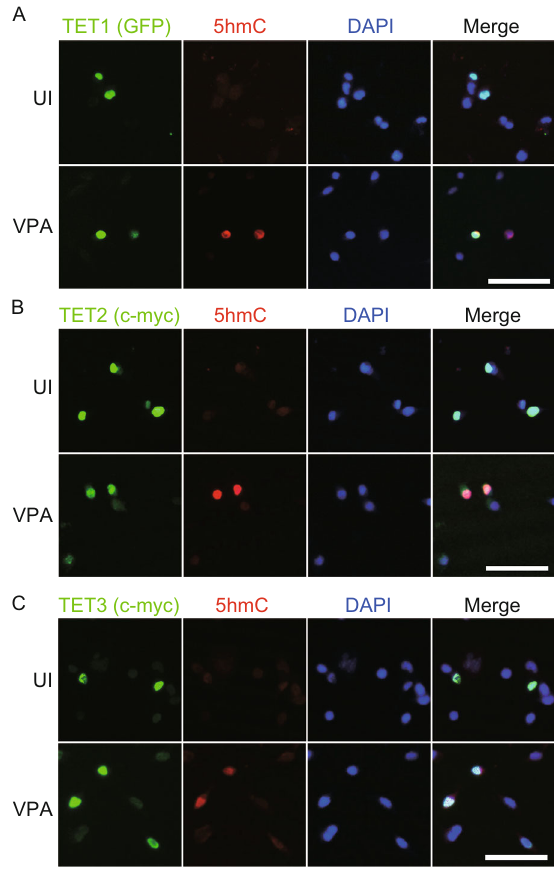
Figure 4. Overexpression of TET proteins increased 5hmC levels in differentiated Neuro2a cells. (A – C) Neuro2a cells were cultured in high glucose DMEM containing 10% FBS (UI) or in opti-MEM containing 1 mmol/L VPA (VPA). 5hmC and the expression of GFP tagged TET1 (A), c-myc tagged TET2 (B), or c-myc tagged TET3 (C) was detected by co-immuno fl uores- cence